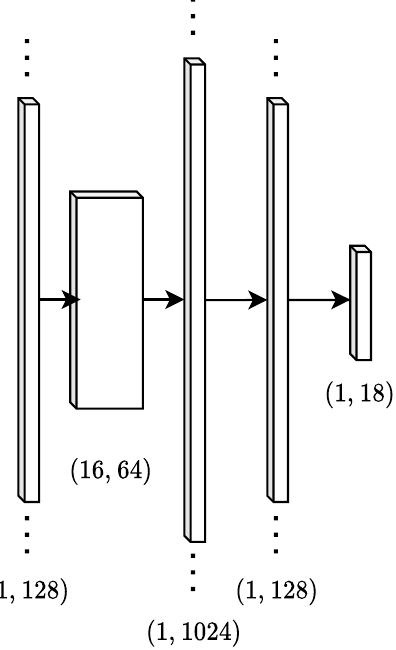
Figure 2. Example architecture of a convolutional identification network, in a similar fashion to refs. [12,13]. A 2-dimensional feature map resulting from convolutional operations is flattened into a single feature vector of length 1024, and this is reduced down to the output size of 18 (17 sources, 1 background channel). A max-pooling operation is applied to the features resulting from the convolutional operation, reducing feature size from 128 to 64. In the case of an RNN, the dense layer with size (1, 128) at time t is fed back to combine with the previous layer at time t + 1. Not shown here is a softmax function that the output is fed